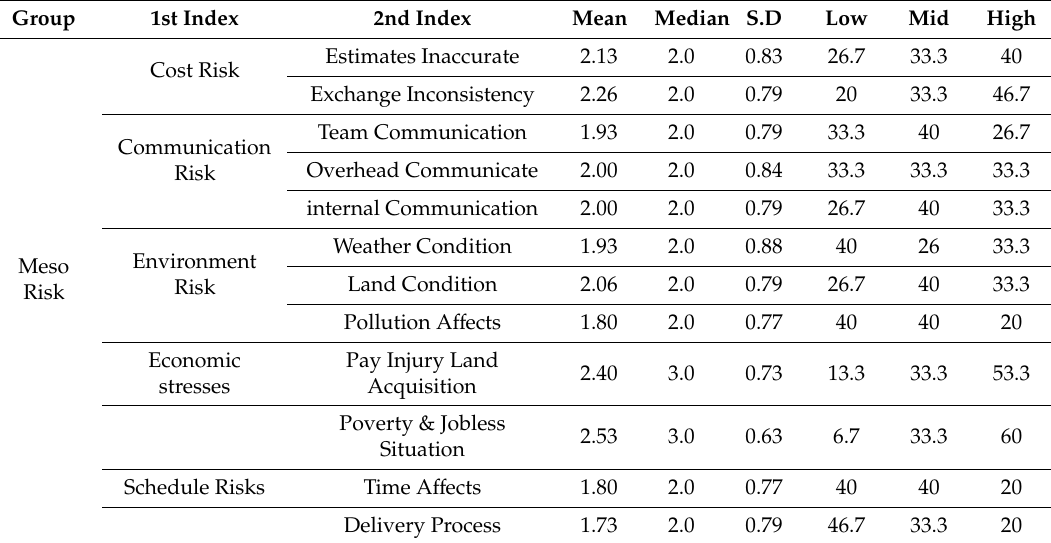
Table 4. Meso-level risk for round